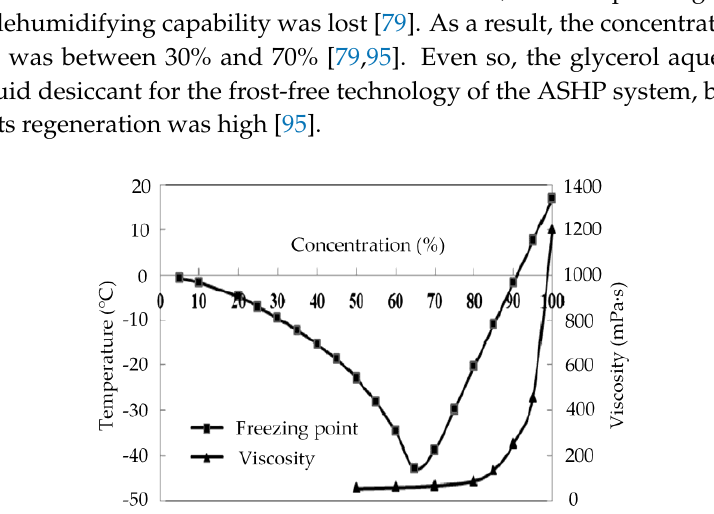
Figure 15. The freezing point and viscosity of glycerol solution at different concentrations [79].